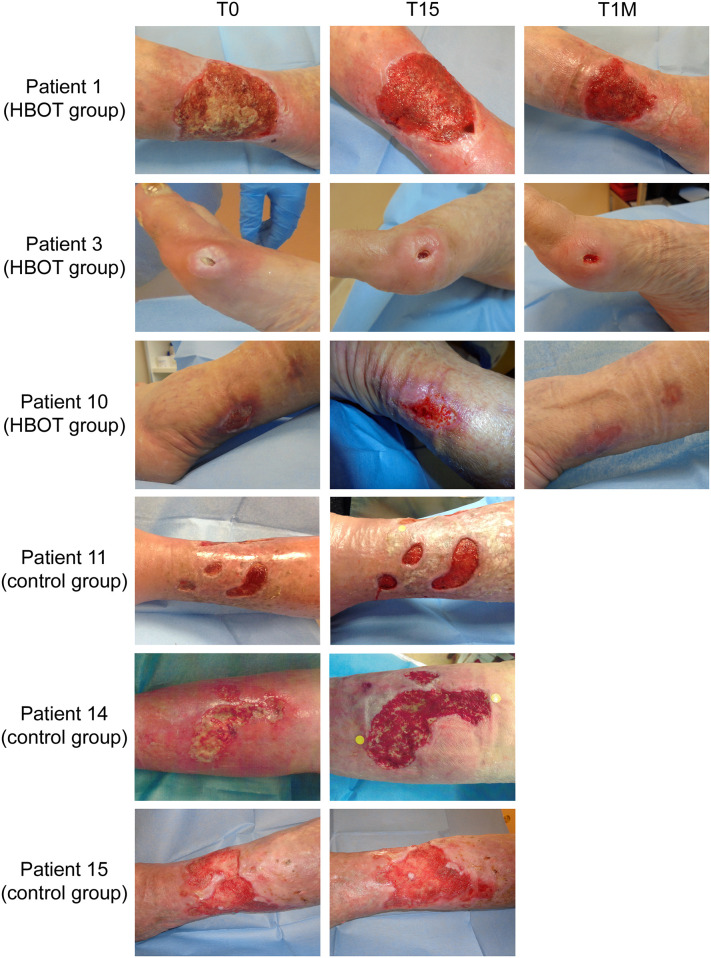
Wound healing progression during and after HBO therapy in patients with chronic non-healing wounds, shown qualitatively.Images of the same ulcer were acquired before (T0), after 15 HBO sessions (T15) and one month after the last HBO treatment (T1M) for patients of HBOT group; during the first evaluation (T0) and after fifteen days of standard wound therapy (T15) for control group patients. Three representative sets of wound images for each group are shown.